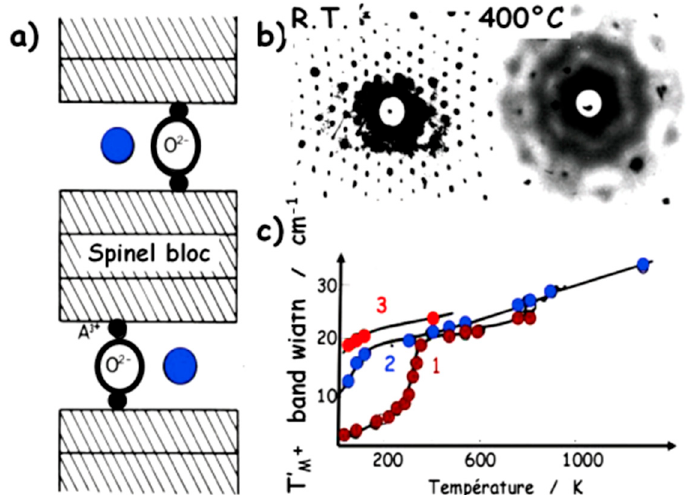
Figure 5. Influence of a small stoichiometry shift. Schematic of the β -alumina structure: ( a ) the two sublattices; the dense-packed spinel blocks connected to an Al–O–Al bridge and the open plan allowing for the fast diffusion of conducting cations (in blue); ( b ) comparison of the X-ray diffuse scattering measured for Ag β -alumina before the melting temperature of the Ag + sublattice (R.T., the numerous peaks arise from the superstructure of the Ag cations before the superionic state) and above (400 °C; the rings come from the liquid state of the Ag + ions; the remaining Bragg peaks come from the host alumina framework); ( c ) band broadening of the characteristic Raman T’ mode of the Ag + ion for ion-rich (1.66), standard (1.25) and stoichiometric β -alumina (1 Ag 2 O·11Al 2 O 3 ) [191,192]. The shift in the stoichiometry displaces the transition from ‘standard’ to superionic state for many hundreds of degrees.